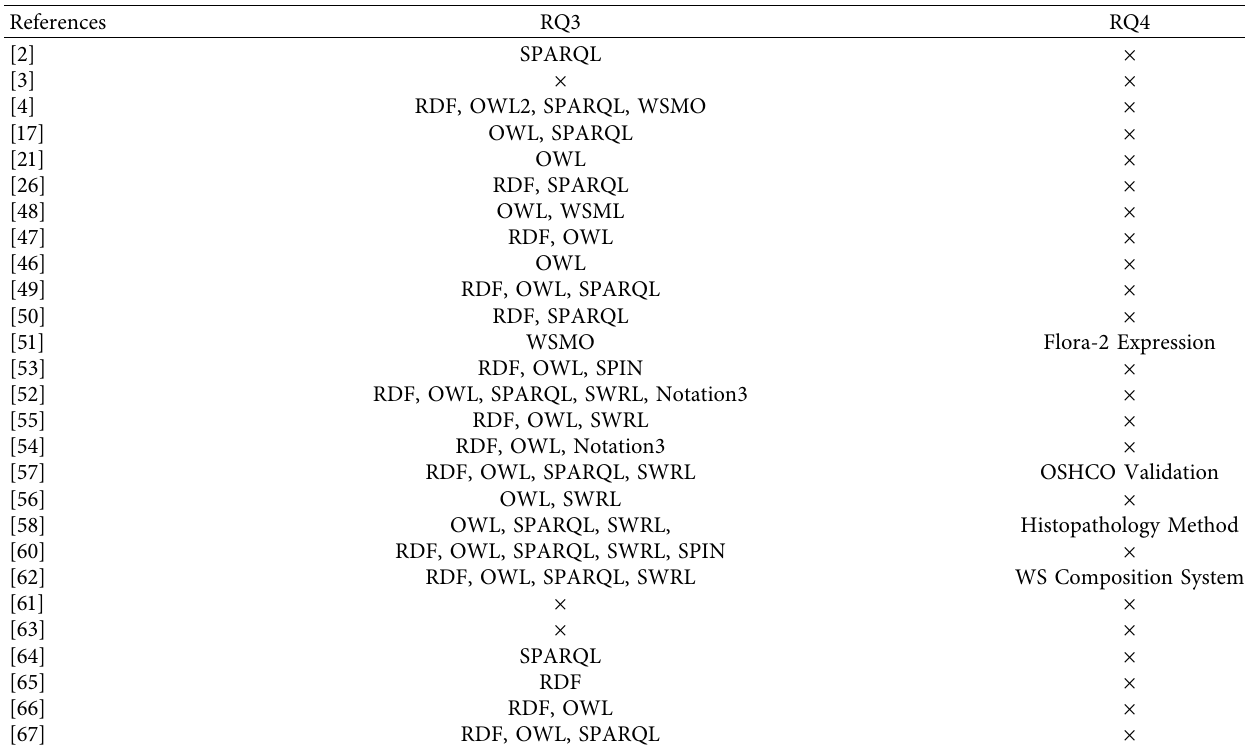
Table 6: Summary of Semantic Web technologies used in e-healthcare